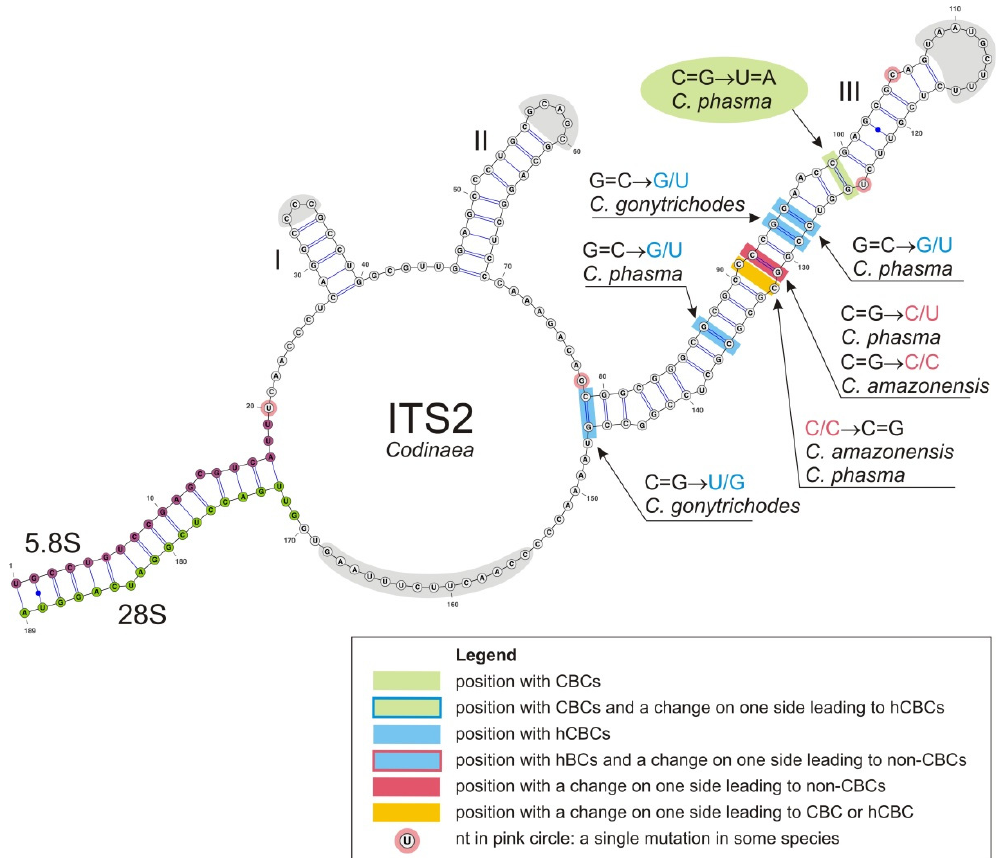
Figure 4. ITS2 secondary structure of Codinaea assamica CBS 139907 and 5.8S-28S rRNA gene hybridization (proximal stem region) (GenBank accessions ITS: OL654077, 28S: OL654134). ITS2 helices are numbered I–III. All substitutions recorded among members of Codinaea are mapped on the 2D model. Identified substitutions are color-coded: CBC (green), hCBC (blue), and non-CBC (red). Parts of the text in green frames refer to CBCs, parts of the text in blue and red refer to hCBCs and non-CBCs, respectively. Hairpin loops and other parts of the ITS2 molecule highlighted with grey color represent regions with a variable number of nucleotides or sequence variation; positions highlighted with a pink color represent single mutations.